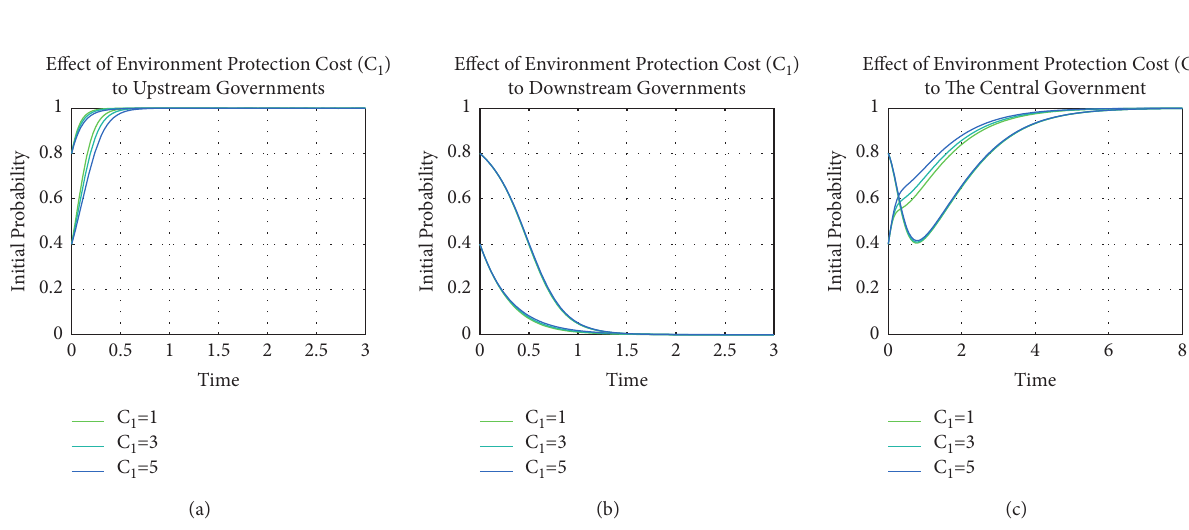
Figure 4: The effect of environmental protection cost ( C ) on each player. (a) Effect of environment protection cost ( C 1 ) on upstream 1 governments. (b) Effect of environment protection cost ( C 1 ) on downstream governments. (c) Effect of environment protection cost ( C 1 ) on the central